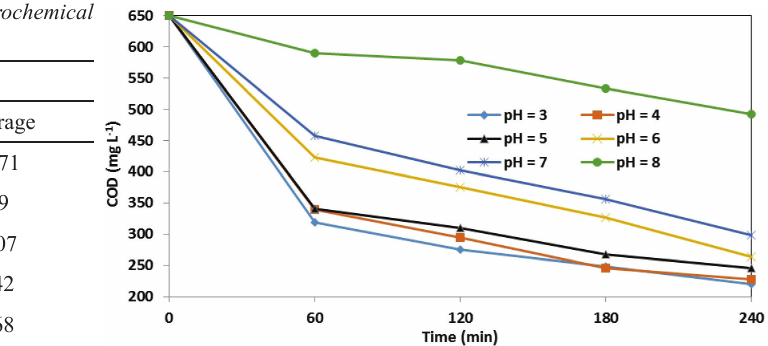
Fig. 1 – Effect of pH on COD removal of high salinity petro- chemical wastewater using PPC (Electrode distance: 2 cm, voltage: 1 V, reaction time: 240 min, uV lamps: 2)